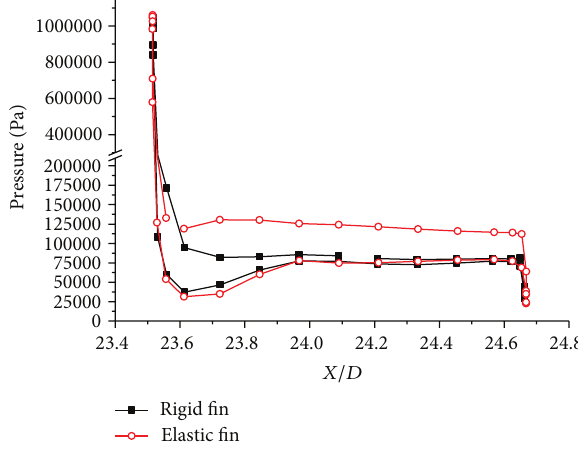
Figure 13: Pressure versus 𝑥 -position on the intersecting line of 𝑦 = 0.3 msectionofthewrapfinofspinningrocketatMa = 3 and 𝛼 = 4 ∘